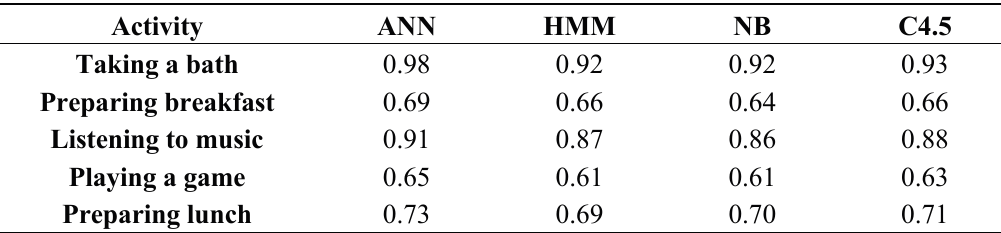
Table 6. Activity recognition with data of one